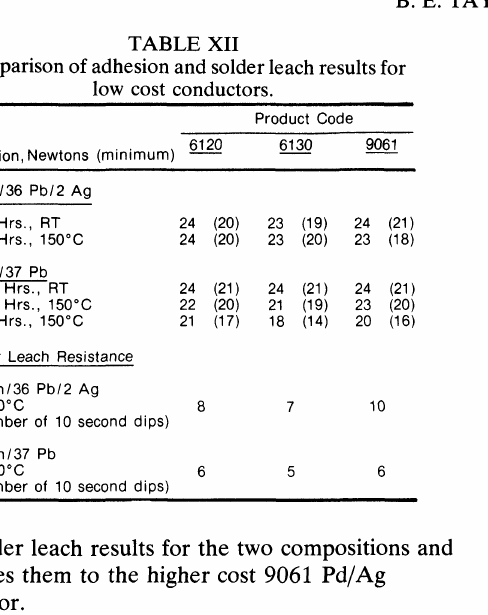
TABLE XIII Comparison of binders for several low cost conductor